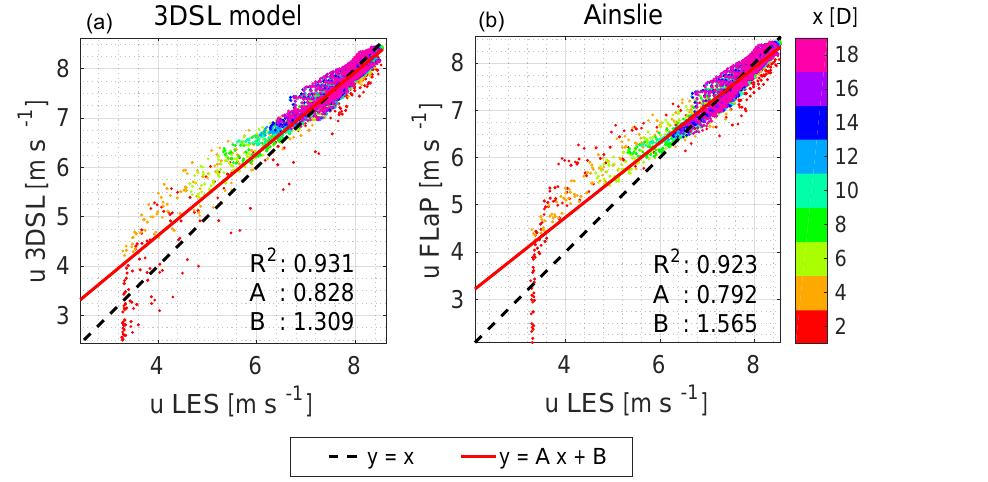
Figure 6. Test case 1 (single wake). Scatter plot and corresponding regression line of the wind speed derived from the 3DSL model (a) and from the FLaP wake simulations in relation to the reference wind field calculated with large-eddy simulations